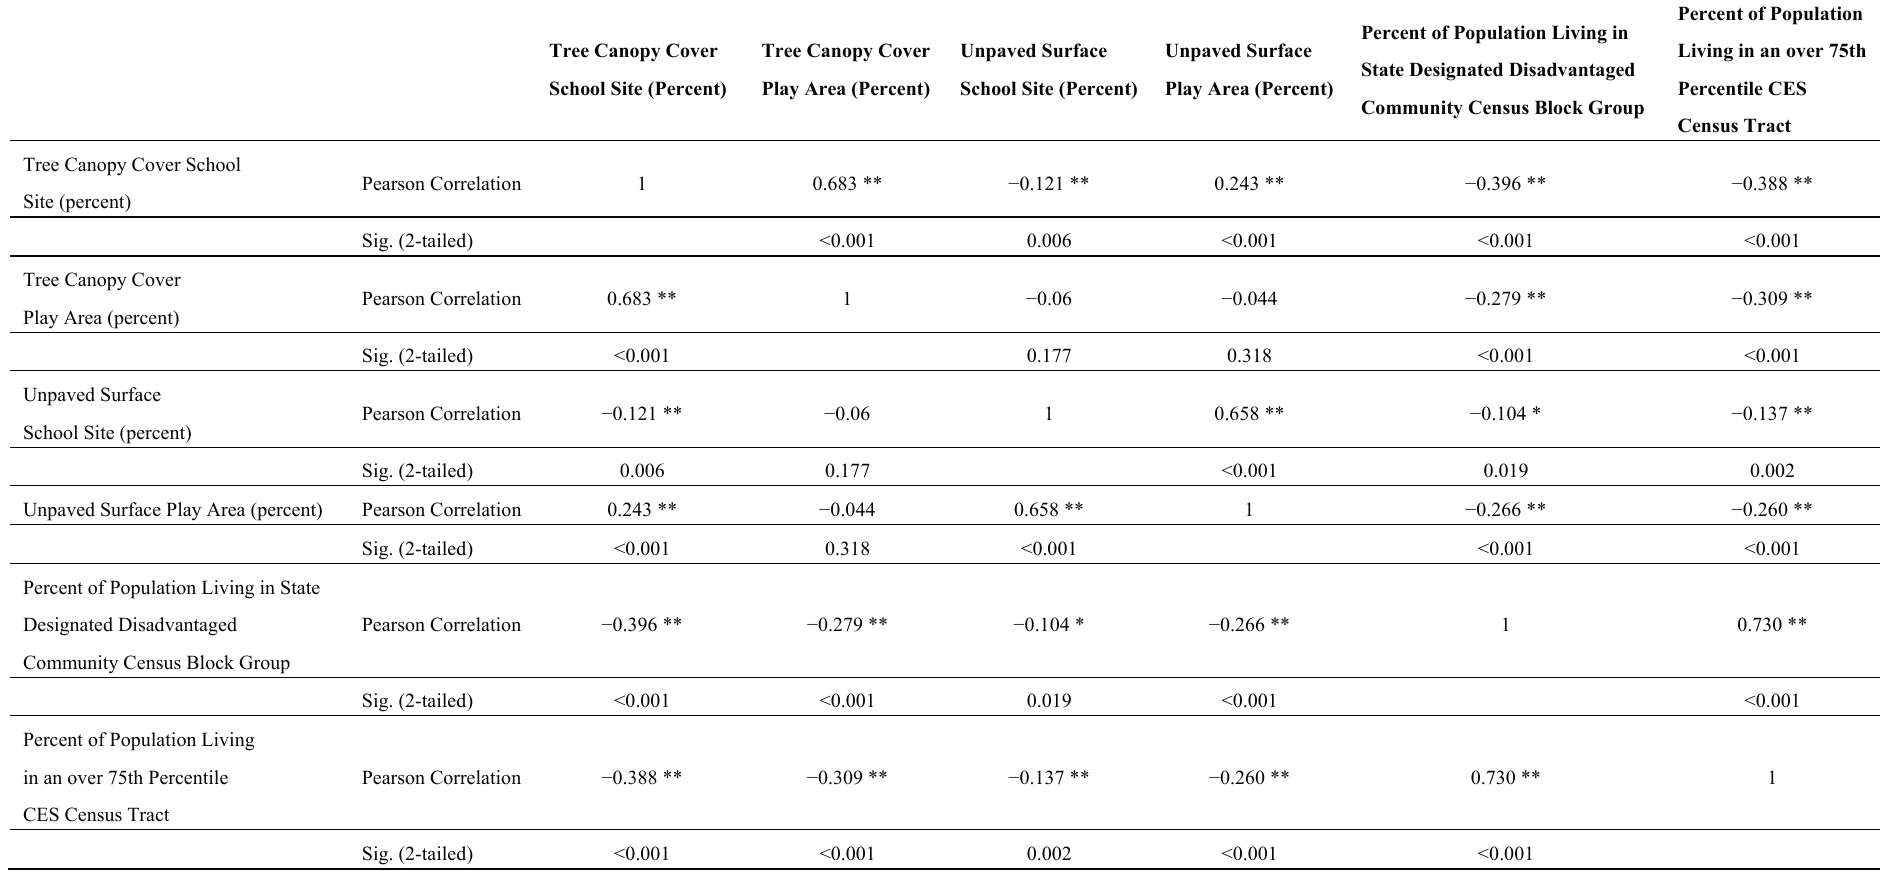
Table 3. Correlations for Tree Canopy and SED Status of School Sites (N =